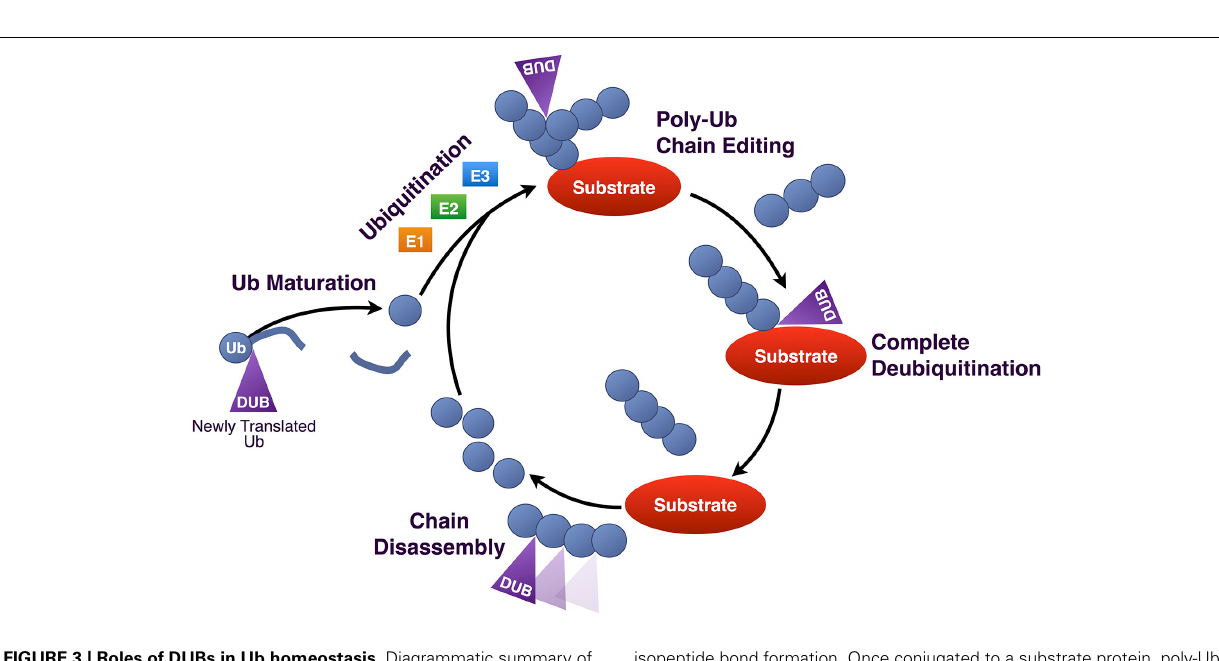
isopeptide bond formation. Once conjugated to a substrate protein, poly-Ub chains can be edited, or can be completely removed. Poly-Ub chains that are unanchored are processed into single Ub and re-enter the Ub conjugation